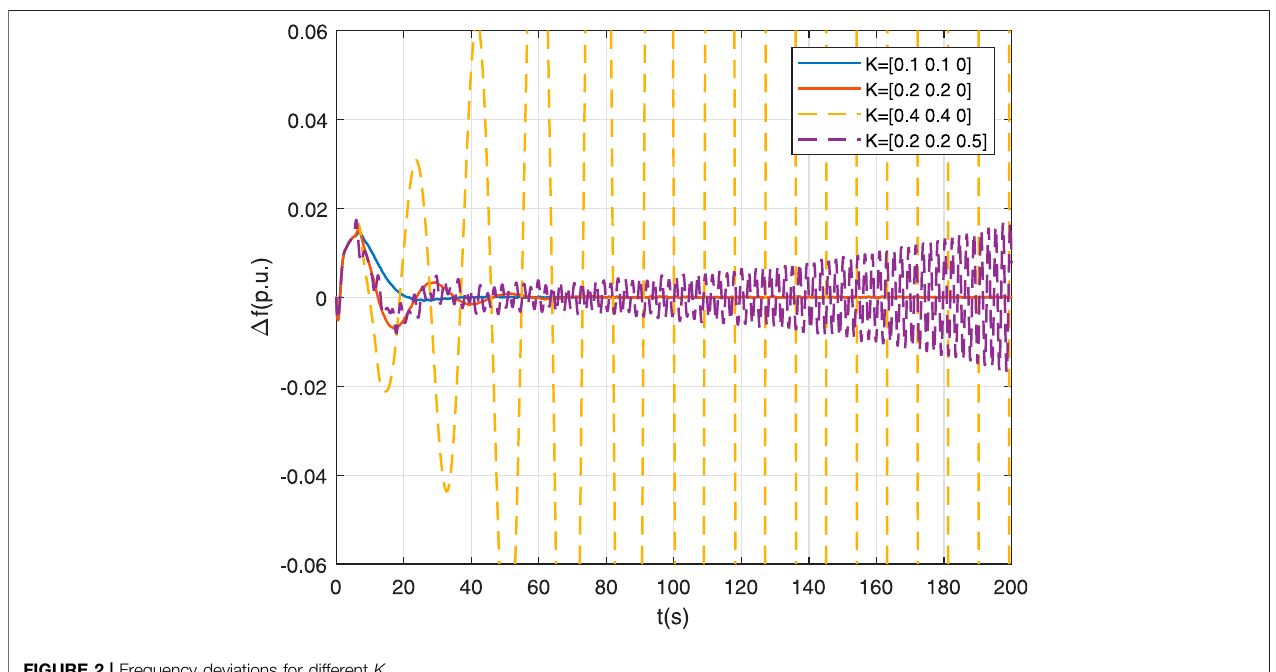
FIGURE 2 | Frequency deviations for different K .